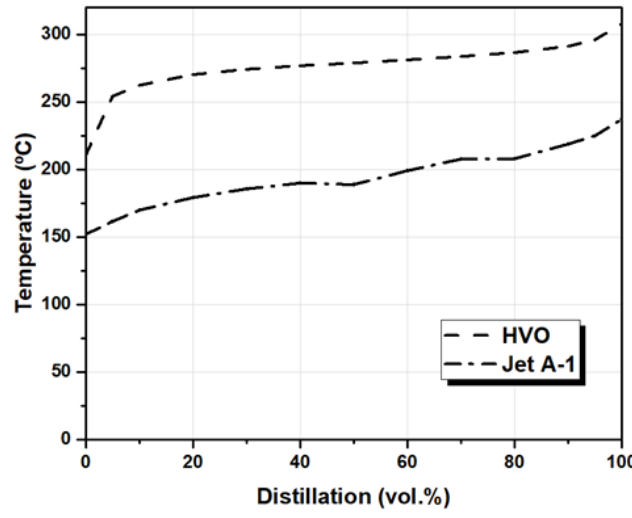
Figure 1. Distillation curve for Jet A-1 and HVO.